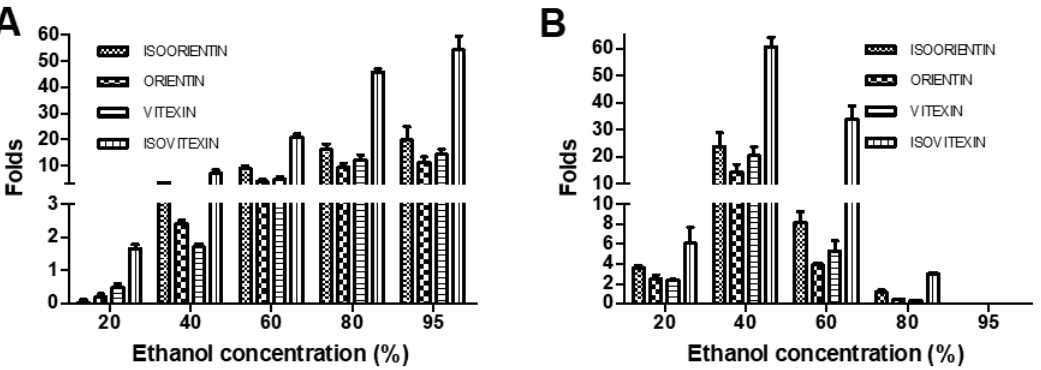
Figure 6. Enrichment of flavonoid C -glycosides from OPLAH by the isocratic elution mode ( A ) and gradient elution mode ( B ) on the XAD7HP resin. Each value is the average reading from three replicates (n = 3).